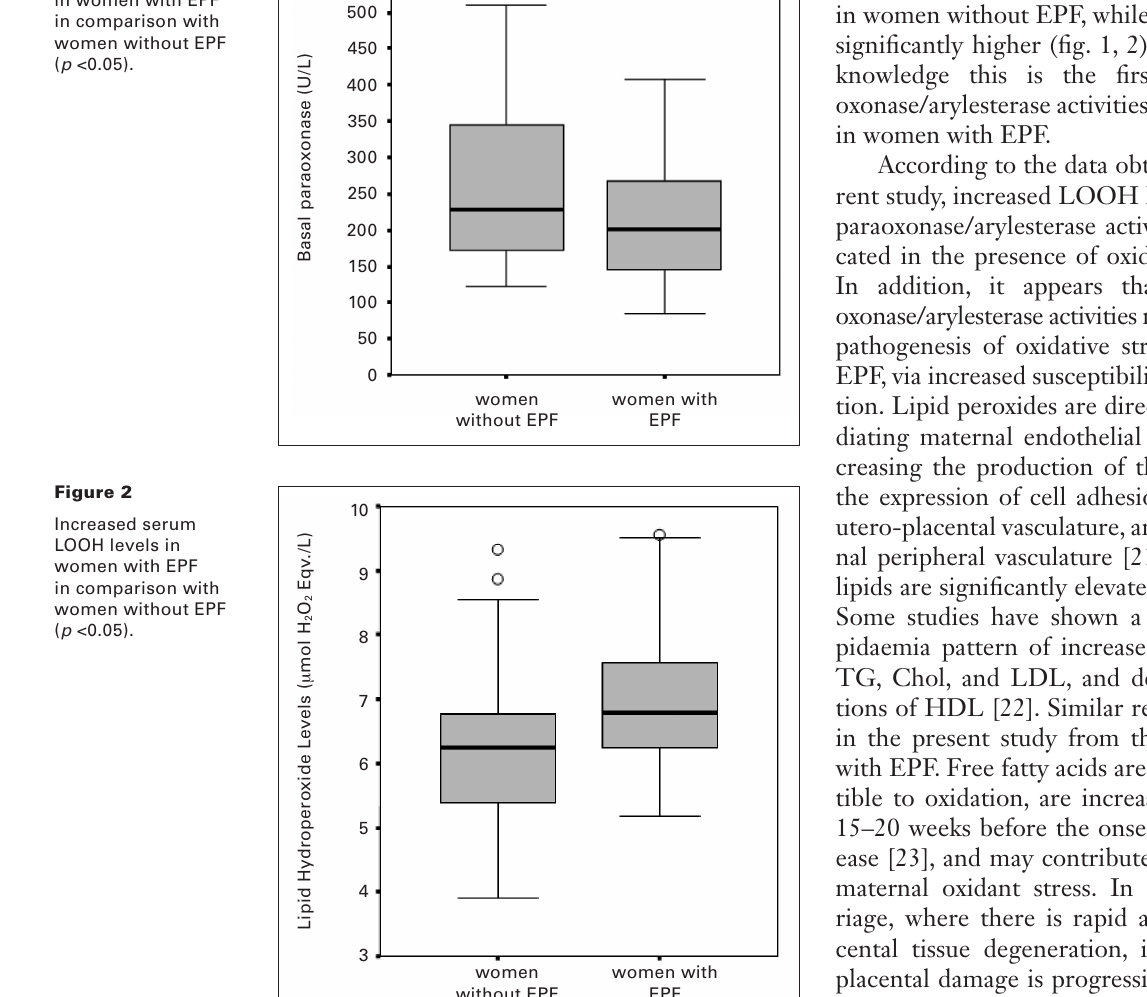
Reduced serum basal paraoxonase activity in women with EPF in comparison with women without EPF ( p <0.05).